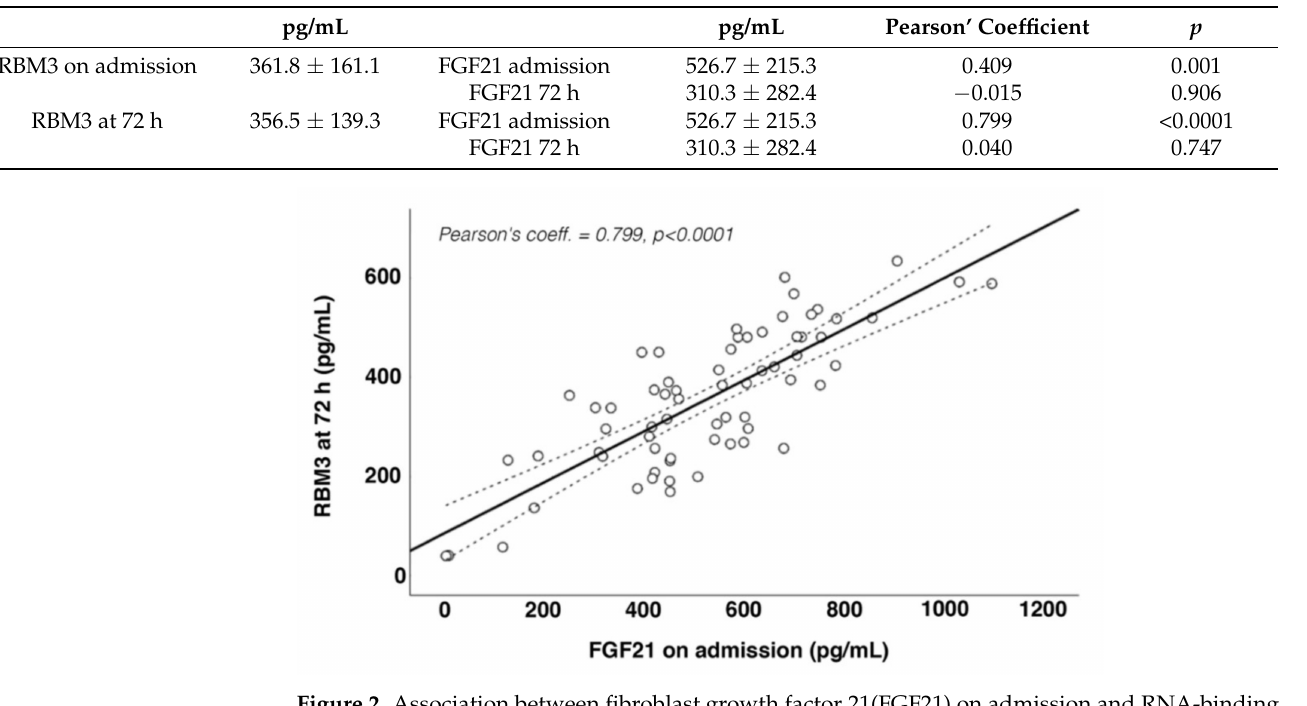
Figure 1. Profile level of fibroblast growth factor 21 (FGF21) ( a ) and RNA-binding motif protein 3 (RBM3) ( b ) on admission, 72 h and 7 days. Table 2. Correlation of fibroblast growth factor 21 (FGF21) and RNA-binding motif protein 3 (RBM3) on admission and at 72 h.